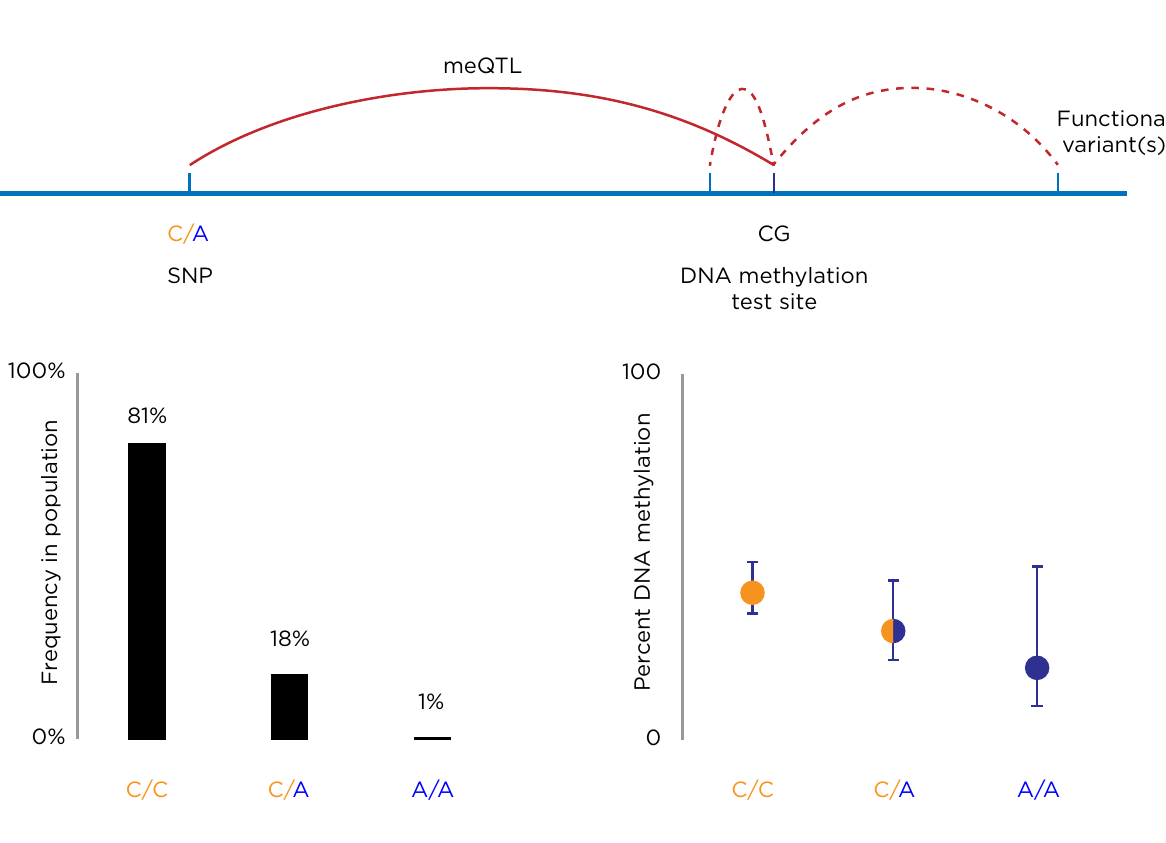
Fig 2. An illustration of a methylation quantitative trait locus (meQTL). These are identified by finding a difference in DNA methylation between individuals that correlates with having one or other allele for a DNA sequence variant, in this case showing a variant on the same chromosome (a cis -meQTL). A significant change in DNA methylation associated with these differing allelic states defines the meQTL. Whether the meQTL causes the DNA methylation change is less certain—within the haplotype containing the meQTL and the locus where DNA methylation was tested will include other DNA sequence variants, one or more of which could be directly influencing the DNA methylation as a functional